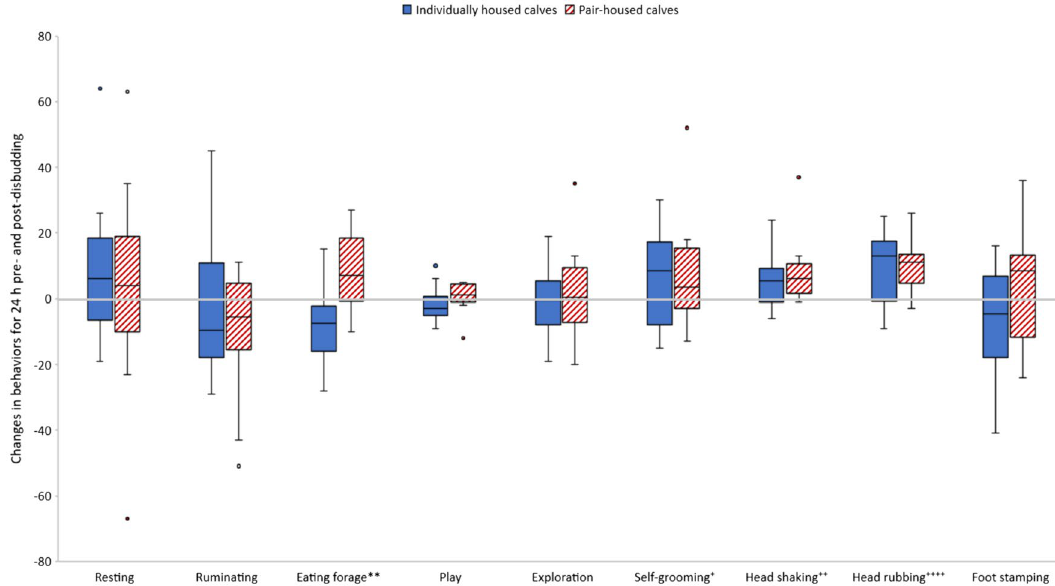
Figure 1. Changes in behaviors after disbudding calculated as difference between post-and pre-disbudding behavior. Disbudding significantly increased head-shaking, head-rubbing and self-grooming in all calves. Eating forage significantly increased only in PAIR calves which resulted in a significant difference between housing treatments. The boxplots depict median, interquartile range, data range as whiskers and outliers as circles. Blue boxes: Individually housed calves (n = 10). Hatched red boxes: Pair-housed calves (n = 12). Asterisks represent statistically significant differences between treatments (**P ≤ 0.01), crosses indicate statistically significant differences of all calves from zero, i.e., a significant change of the behavior after disbudding ( + P ≤ 0.05, ++ P ≤ 0.01, ++++ P ≤